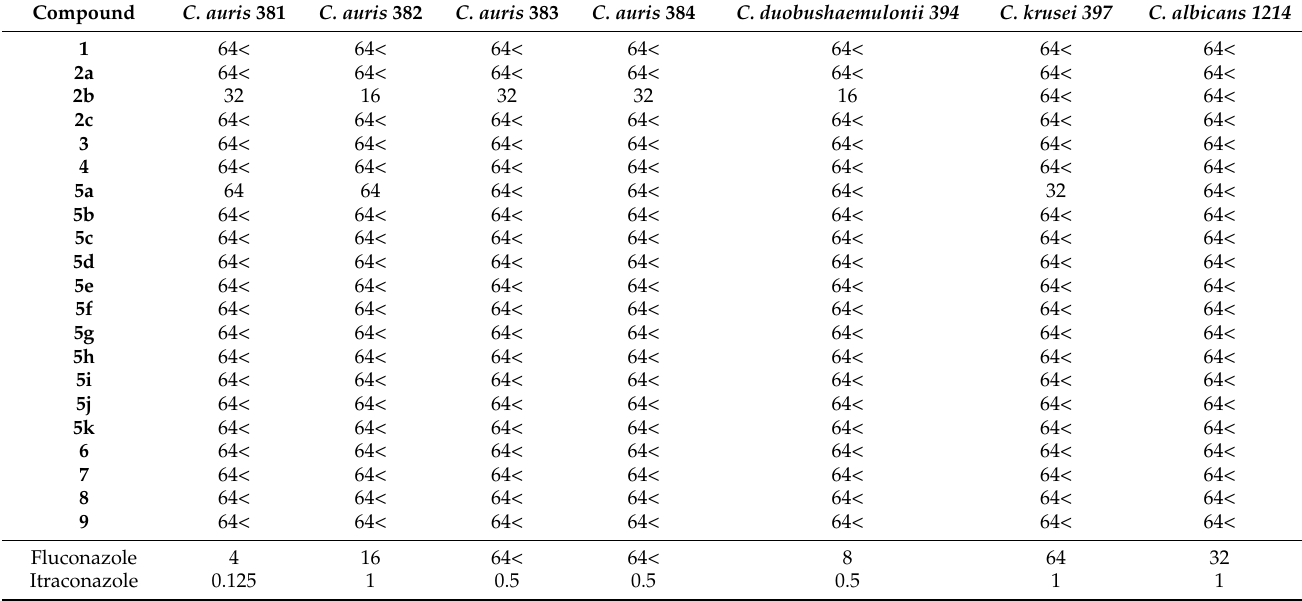
Table 5. The antifungal activity expressed as minimal inhibitory concentration (MIC, µ g/mL) of com- pounds 1 – 9 and comparator drugs (fluconazole, itraconazole) of 1 – 9 against extensively multidrug- resistant Candida spp.